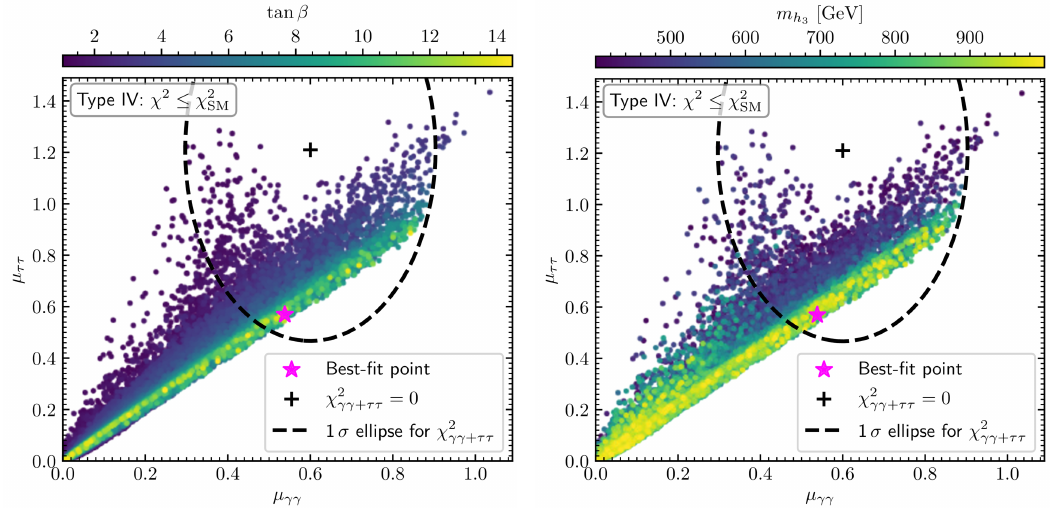
Figure 2 . As in figure 1, but the color coding indicates the value of tan β (left) and of m h µ for a given value of µ ττ of tan β . 5 . In the lower range of tan β we find parameter points that reach values of µ around or above the observed central value µ exp ττ values of tan β is observed with regards to µ